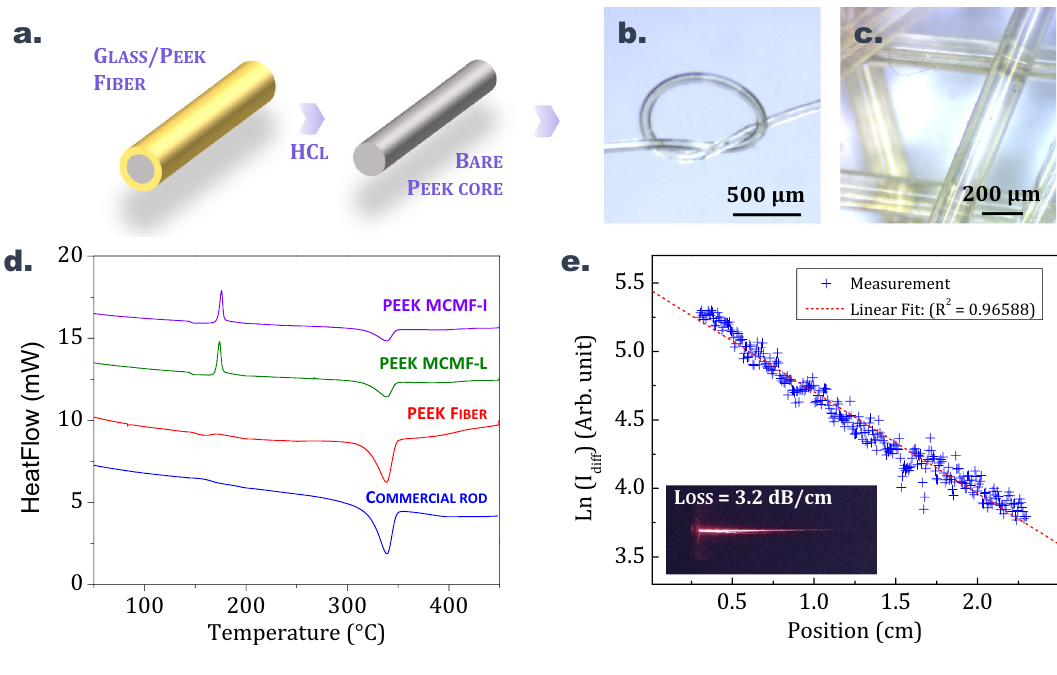
Figure 5. ( a ) Description of how the bare PEEK core samples are obtained from the composite fiber: fiber segments are immerged a few minutes in concentrated hydrochloric acid (HCl ≈6 mol L -1 ) in order to remove the glass cladding. ( b ) and ( c ) Pictures of uncladded and transparent PEEK fibers fabricated by the molten core method. ( d ) DSC curves from which the crystallinities of the different PEEK samples are calculated. ( e ) Optical losses measurement of a bare PEEK core at 633 nm. inset: longitudinal view of the diffused light when propagating through the PEEK